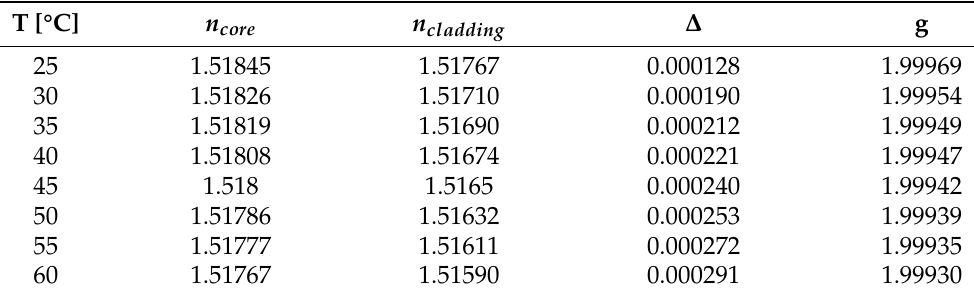
Table 1. Average values of the refractive index measurements (at λ = 638 nm) at different tem- peratures and their calculated ∆ and g-parameters required to calculate the refractive index of the